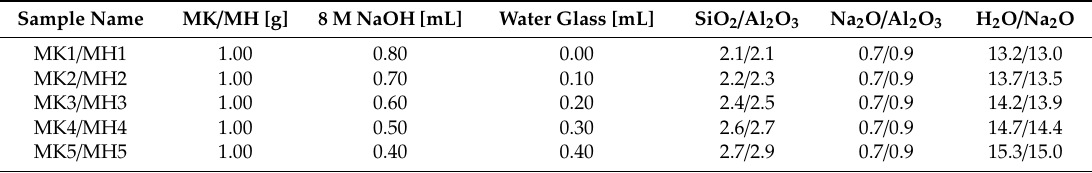
Table 1. The mixture proportions of geopolymer pastes and their molar ratios of silica, alumina, water and sodium